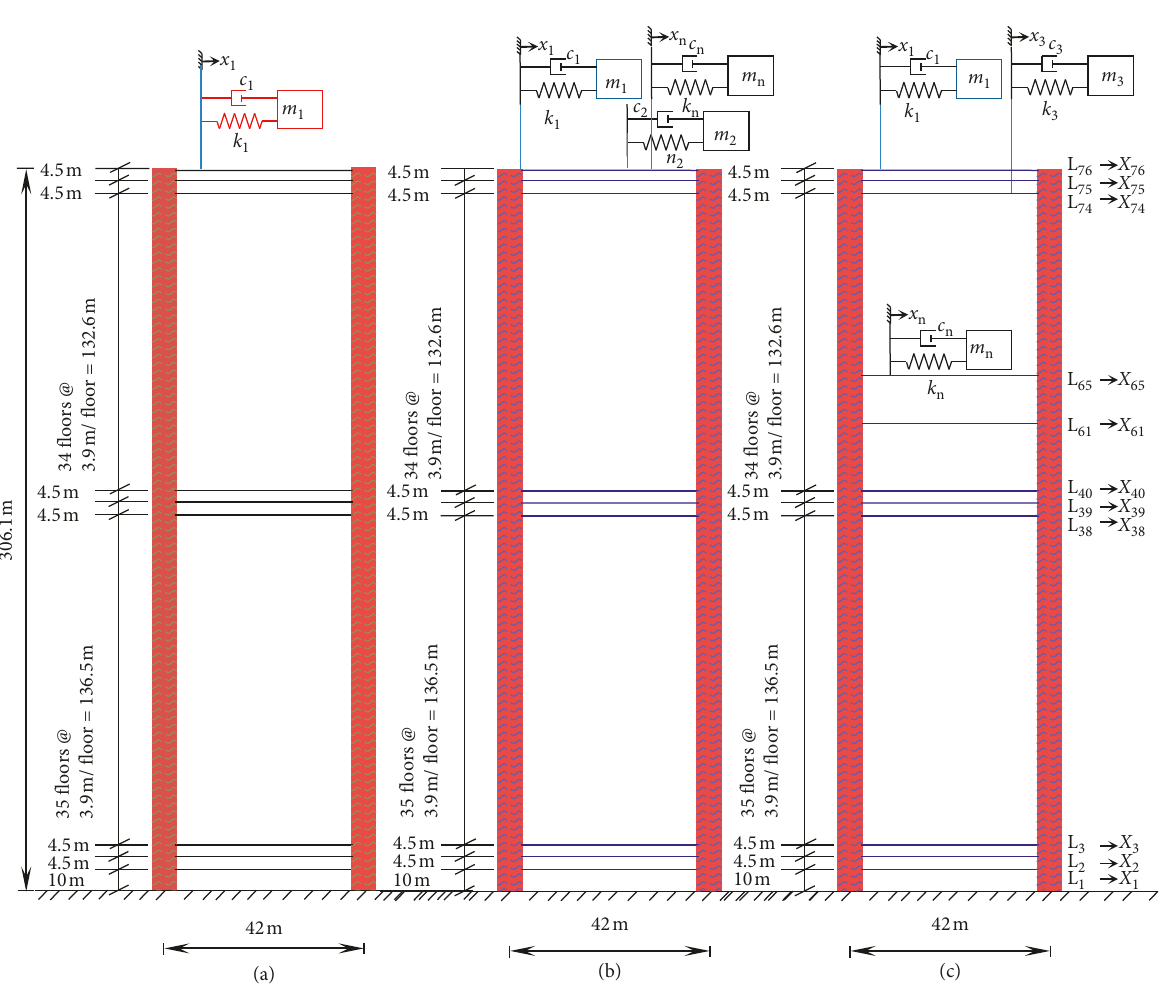
Figure 1: Model of benchmark building (a) installed with STMD, (b) installed with MTMDs, and (c) installed with